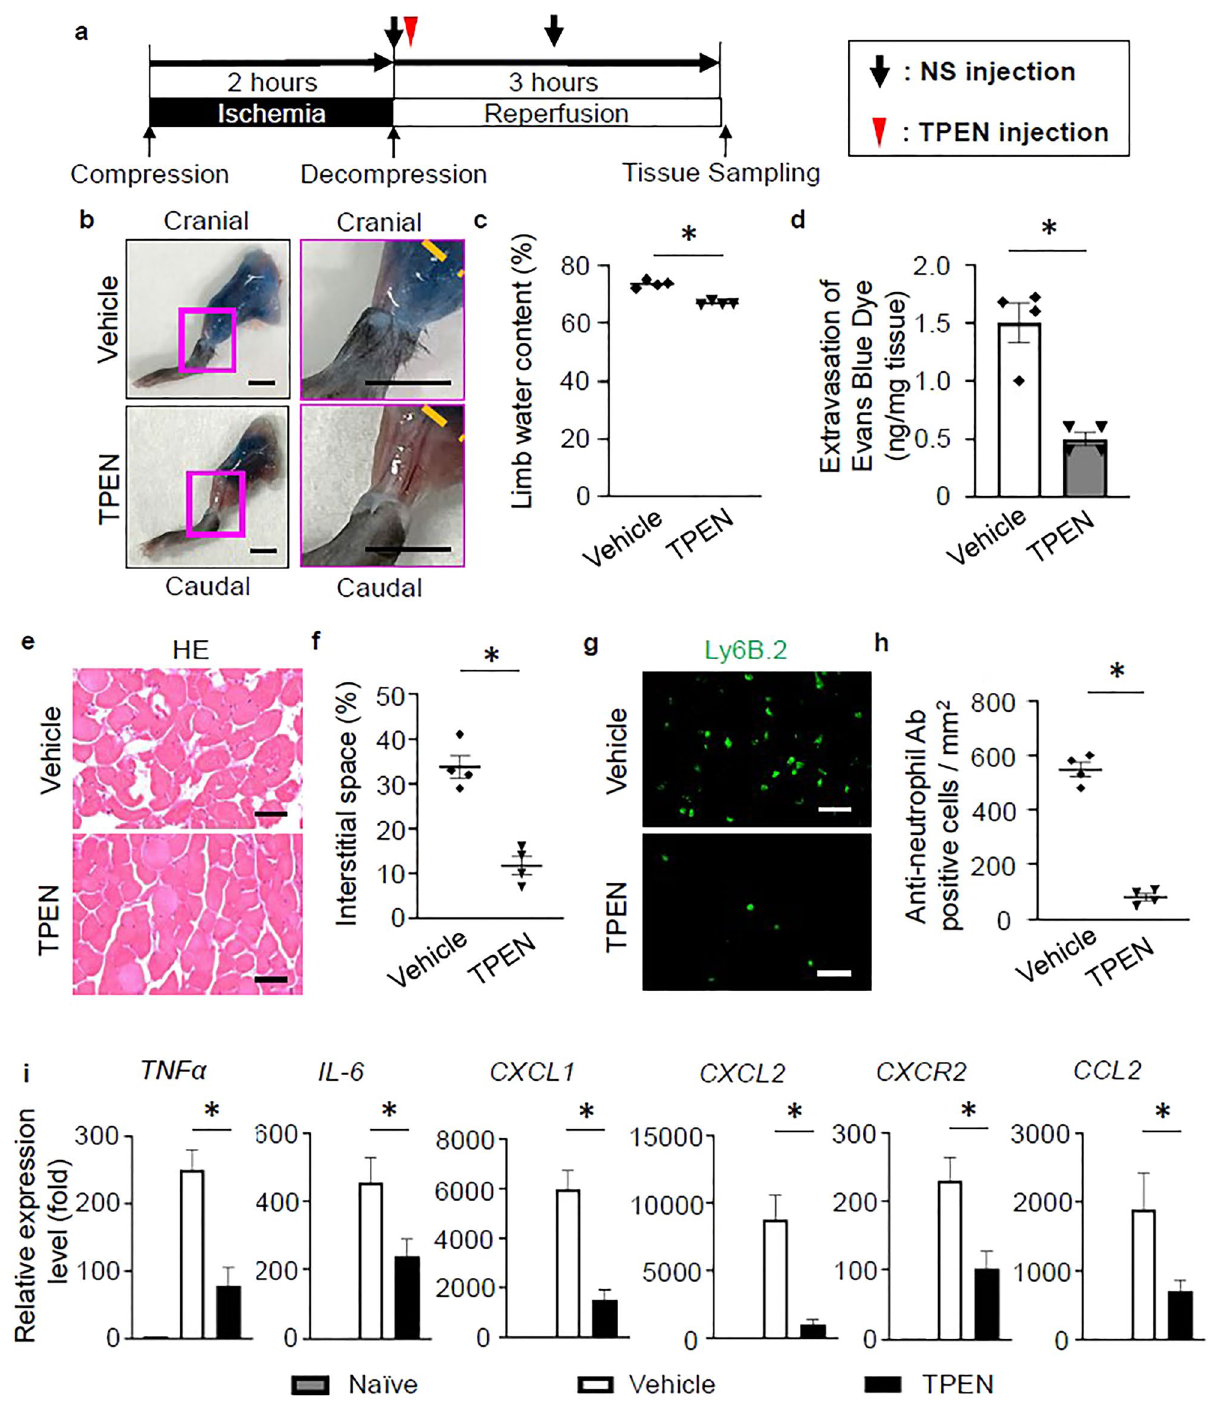
Figure 3. Zinc chelation therapy in crush syndrome reduces neutrophil infiltration, inflammation, and muscle breakdown. ( a ) The zinc chelator treatment protocol, N , N , N ′ , N ′ -Tetrakis (2-pyridylmethyl) ethylenediamine (TPEN) post-reperfusion. ( b ) Representative images of the lower legs with vehicle control and TPEN treatment, following the intraperitoneal injection of EBD. The lower legs with the fascia exposed at 3 h post-reperfusion. The orange dotted line indicates the distal end of the compression site of the hind limb. Scale bars: 5 mm. ( c ) The quantitative analysis of the water content in the hind limbs in the vehicle control and TPEN-treated groups at 3 h post-reperfusion (n = 4 per group). P < 0.05, unpaired t test. ( d ) The quantitative analysis of the extravasation of EBD in the hind limbs of both groups at 3 h post-reperfusion (n = 4 per group). P < 0.01, unpaired t test. ( e ) Representative images of HE-stained gastrocnemius muscle sections, the distal side of the compression site from mice in vehicle control and TPEN-treated groups. Scale bars: 50 μm. ( f ) The quantitative analysis of the interstitial space of the gastrocnemius muscle at mice in vehicle control and TPEN- treated groups (n = 4 per group). P < 0.05, unpaired t test. ( g ) Representative images of muscle tissue specimens stained with Ly6B.2 (green) in vehicle control and TPEN-treated groups (n = 4 per group). P < 0.005, unpaired t test. Scale bars: 50 μm. ( h ) The quantitative analysis of the Ly6B.2 (anti-neutrophil antibody)-positive cell count in vehicle control and TPEN-treated groups (n = 4 per group). P < 0.01, unpaired t test. ( i ) The TNFα, IL-6, CXCL1, CXCL2, CXCR2, CCL2 mRNA expression levels in vehicle control and TPEN- treated groups were compared (n = 4 per group). P < 0.05, unpaired t